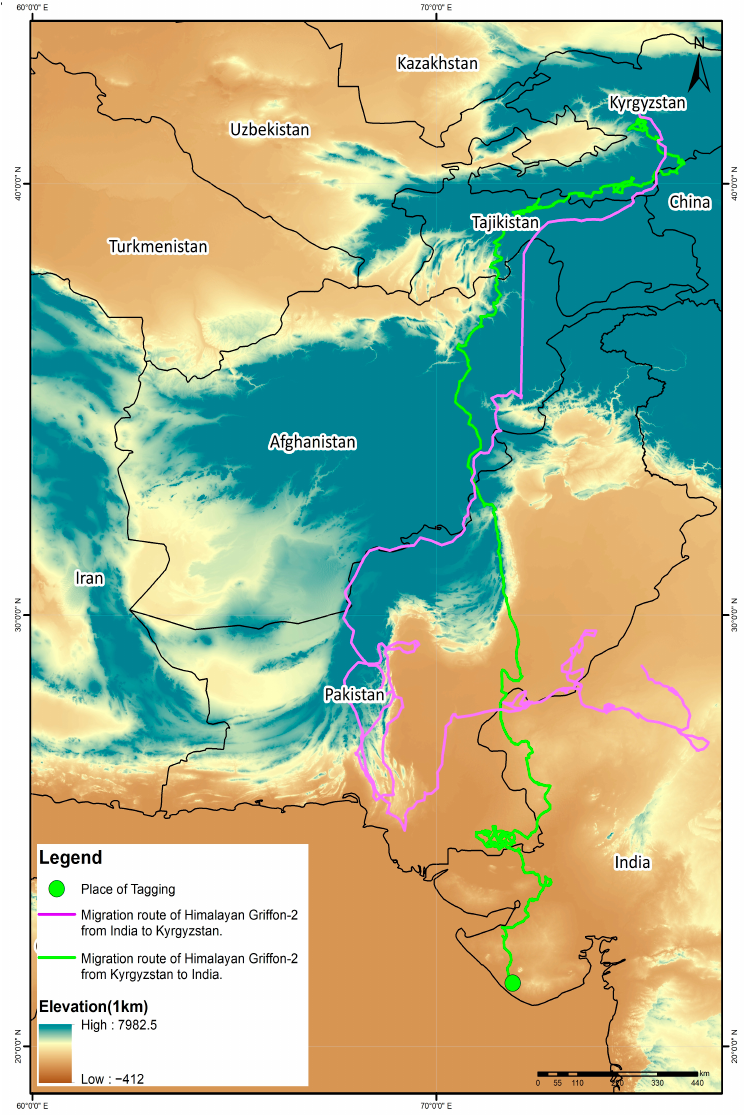
Figure 3. Migration route of Himalayan griffon-2 from Saurashtra Landscape to Kyrgyzstan (green line) during pre-breeding season and from Kyrgyzstan to India (purple line) during post-breeding season. The green dot represents the place of tagging. This map was generated using ArcGIS 10.8.1 (ESRI, Redlands, CA, USA). Country borders represented here are according to Google Earth imagery (Google India).